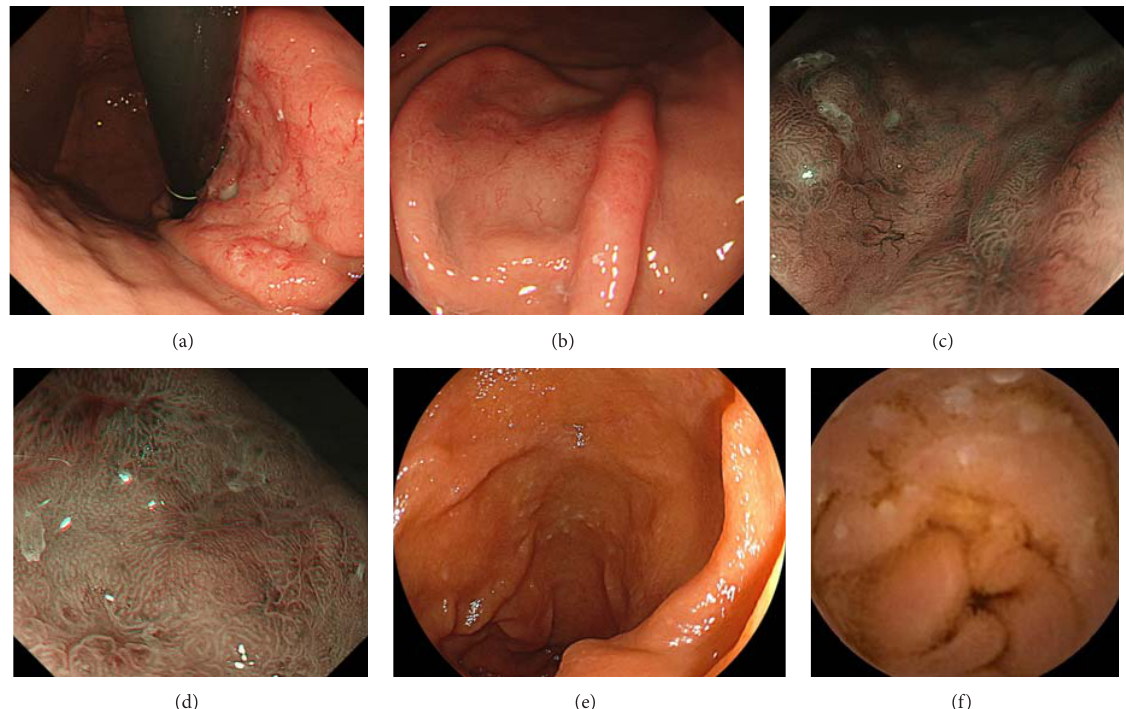
Figure 1: Endoscopic images from case 1. Slightly depressed lesions with thickened peripheral folds were seen in the upper (a) and lower gastric bodies (b). Branched abnormal vessels (c) and irregularly shaped gastric pits (c, d) were observed by using magnifying endoscopy with narrow-band imaging. In the duodenum, multiple whitish depositions were detected (e). Video capsule enteroscopy showed whitish granules in the jejunum (f).